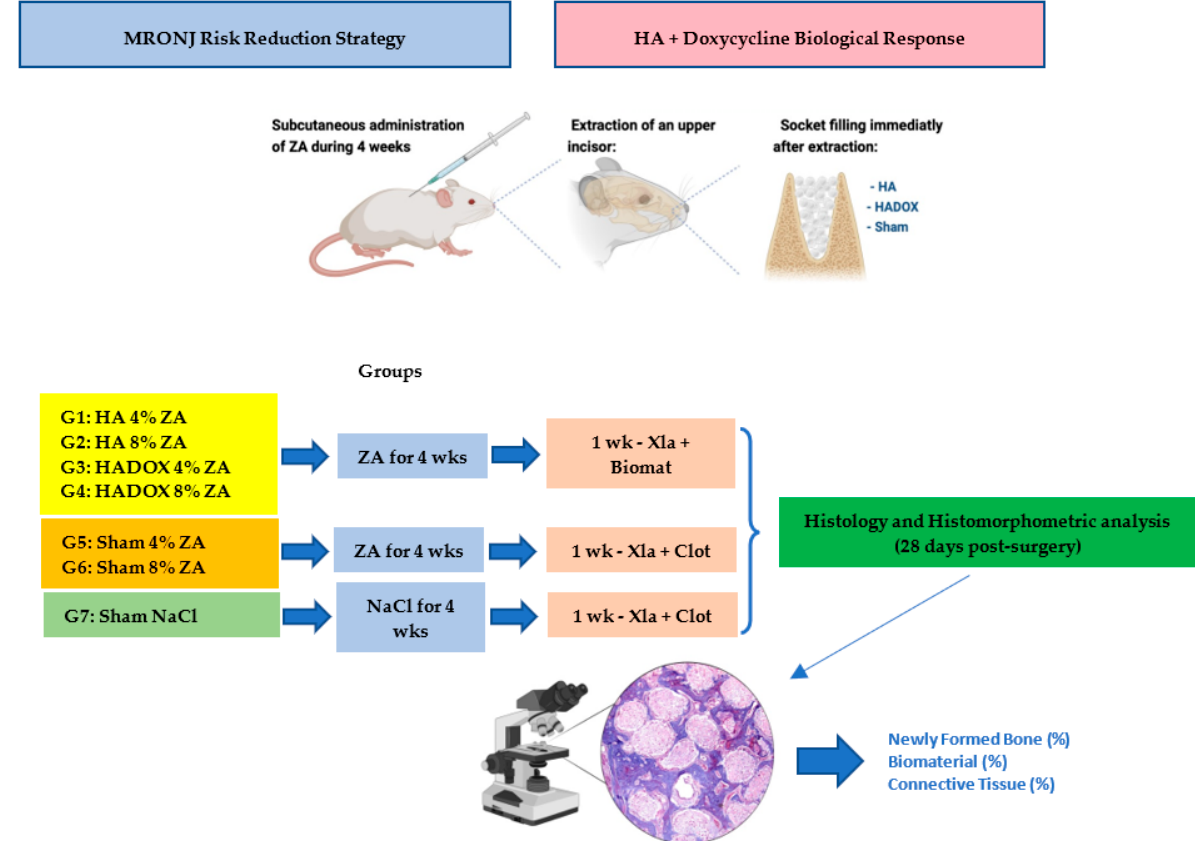
Figure 1. Experiment visual summary. Zoledronic acid (ZA); hydroxyapatite (HA); hydroxyapatite- containing doxycycline (HADOX); weeks (wks); week (wk); dental extraction (xla).